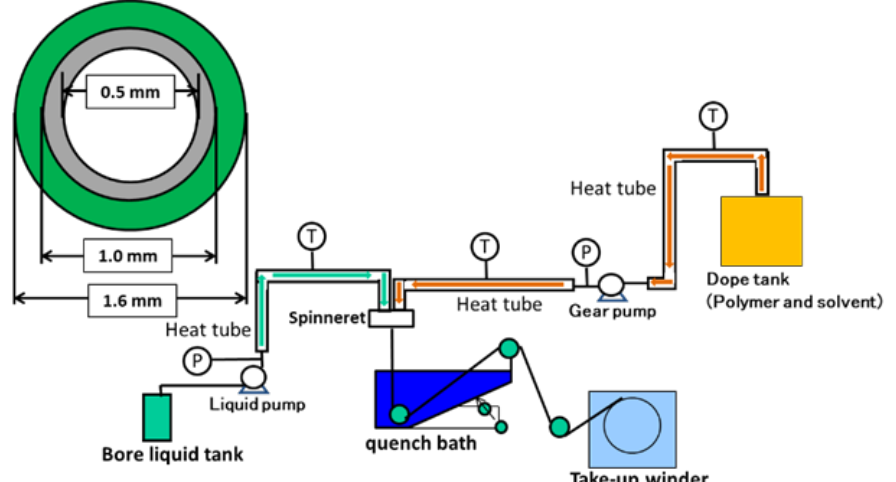
Figure A1. Schematic of the hollow fiber membrane preparation via the NIPS process.